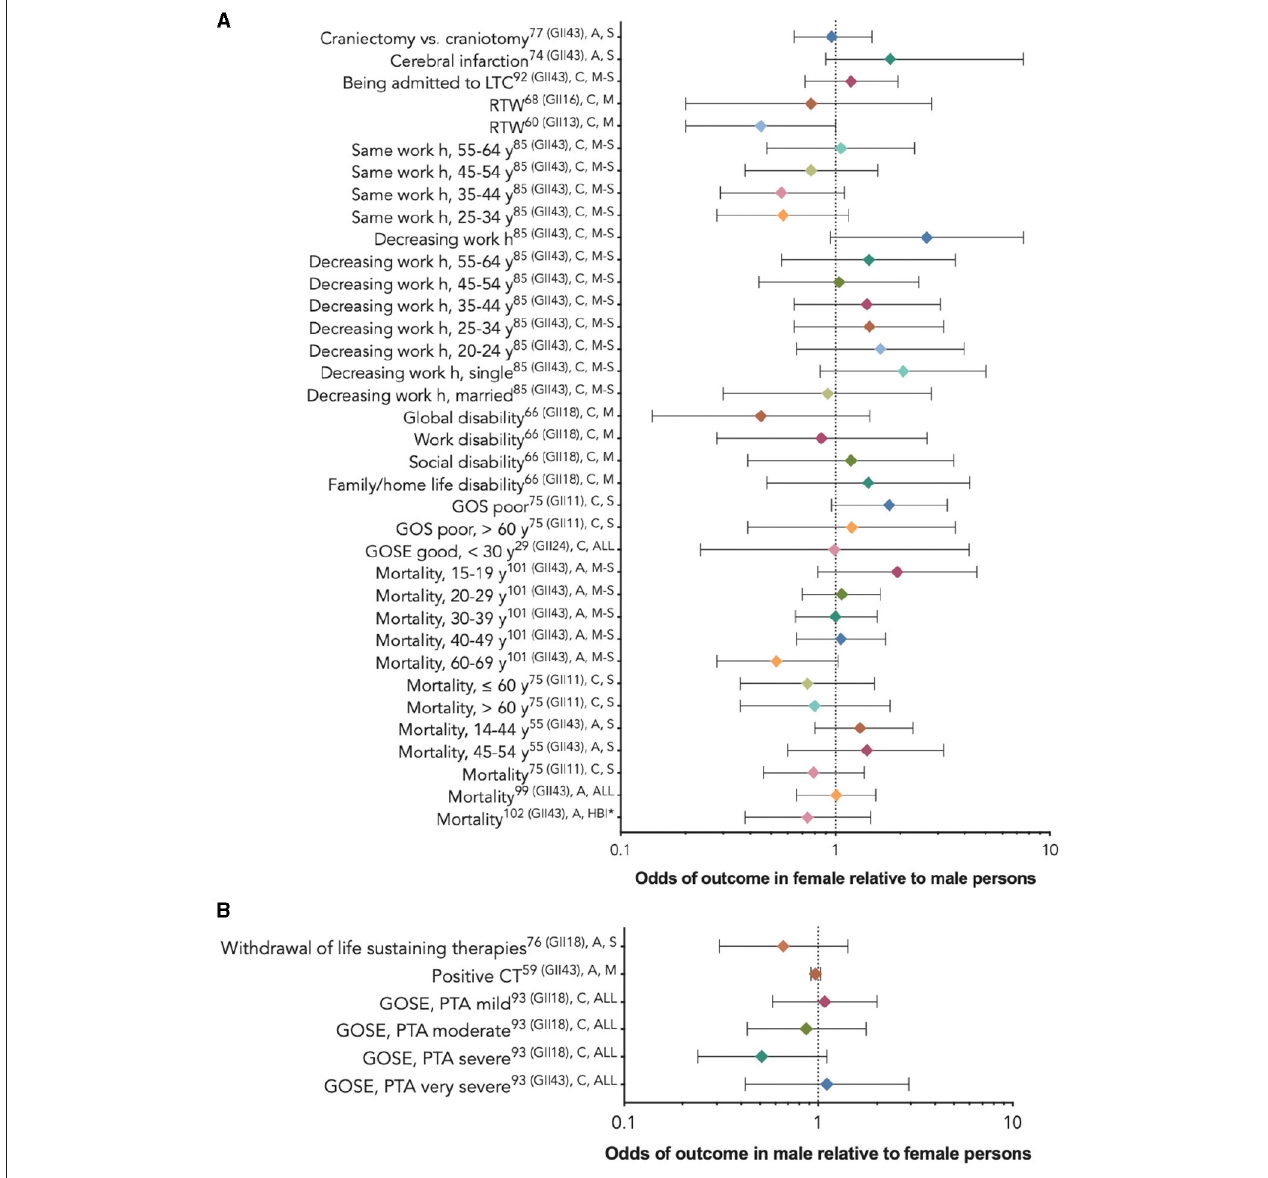
FIGURE 5 | Non-statistically significant sex/gender-related results reported as OR/RR/HR (CI). (A) The outcome odds for female relative to male persons. (B) The outcome odds for male relative to female persons. The error bars represent a 95% confidence interval. The superscript letters indicate the post-injury phase (A, acute; C, chronic; and NR, not reported) and injury severity (M, mild; M-S, moderate-to-severe; S, severe; ALL, all severities; and HBI, hemorrhagic brain injury). *No reference groups in the sex/gender analysis (86).